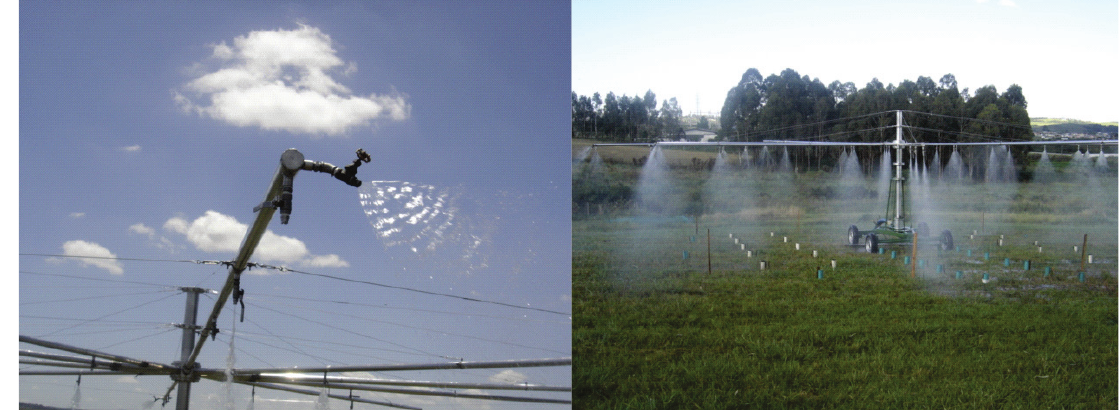
Figura 2. Simulador de chuva movido por empuxo em operação, durante um teste preliminar antecedente à calibração. Esquerda: detalhe de um aspersor utilizado para empuxo; direita: simulador funcionando com 30 registros